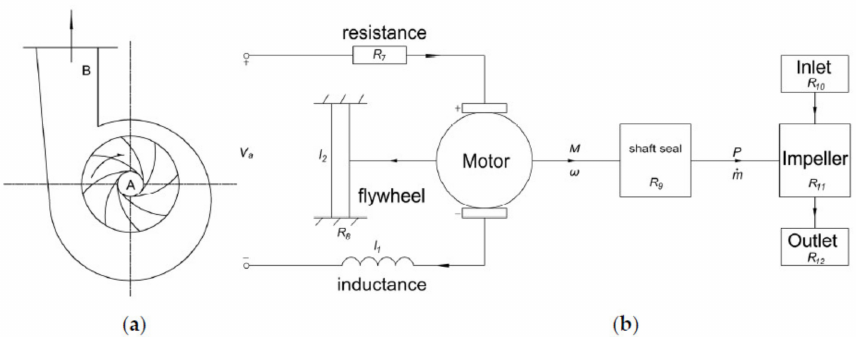
Figure 10. The principle and simplified diagram of the reactor coolant pump: ( a ) working process of reactor coolant pump; ( b ) simplified diagram of the reactor coolant pump principle.